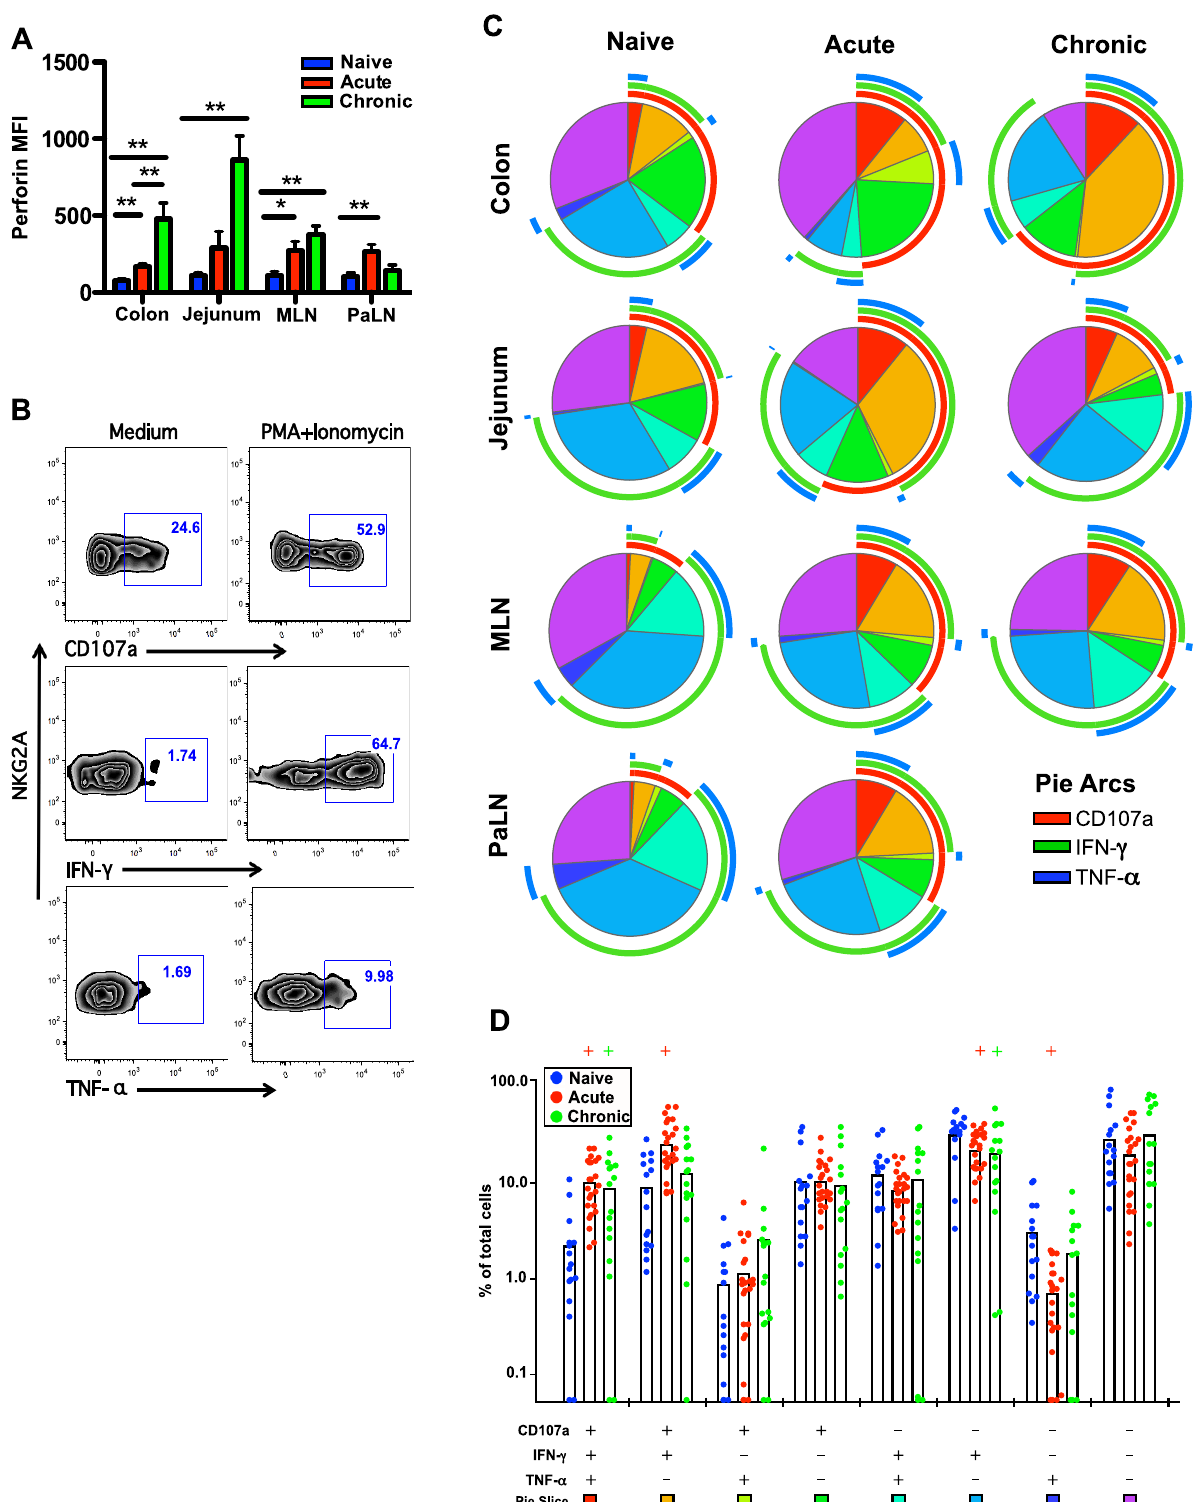
Fig. 5. Comparison of NKG2A + NK cell functions within naı¨ve, acute and chronically SIV-infected macaques. (A) Median fluorescence intensities (MFI) of perforin expression in NKG2A + NK cells ex vivo . (B) Representative flow cytometry plots demonstrating cytokine-secretion profiles of mucosal NKG2A + ILCs following mitogen stimulation. (C) Multiparametric analyses on the data shown in (B) were performed with SPICE 5.0 software. Pies indicate means of 6 to 8 animals per group for each multifunction and arcs show overlap of individual functions. (D) Combined tissue bar comparisons of individual multifunctions. Multifunctions are indicated by rainbow color boxes beneath each combination and correspond to the same colored pie slices in (C). Statistically significant differences between naı¨ve versus acute (red) or naı¨ve versus chronic (green) are indicated;